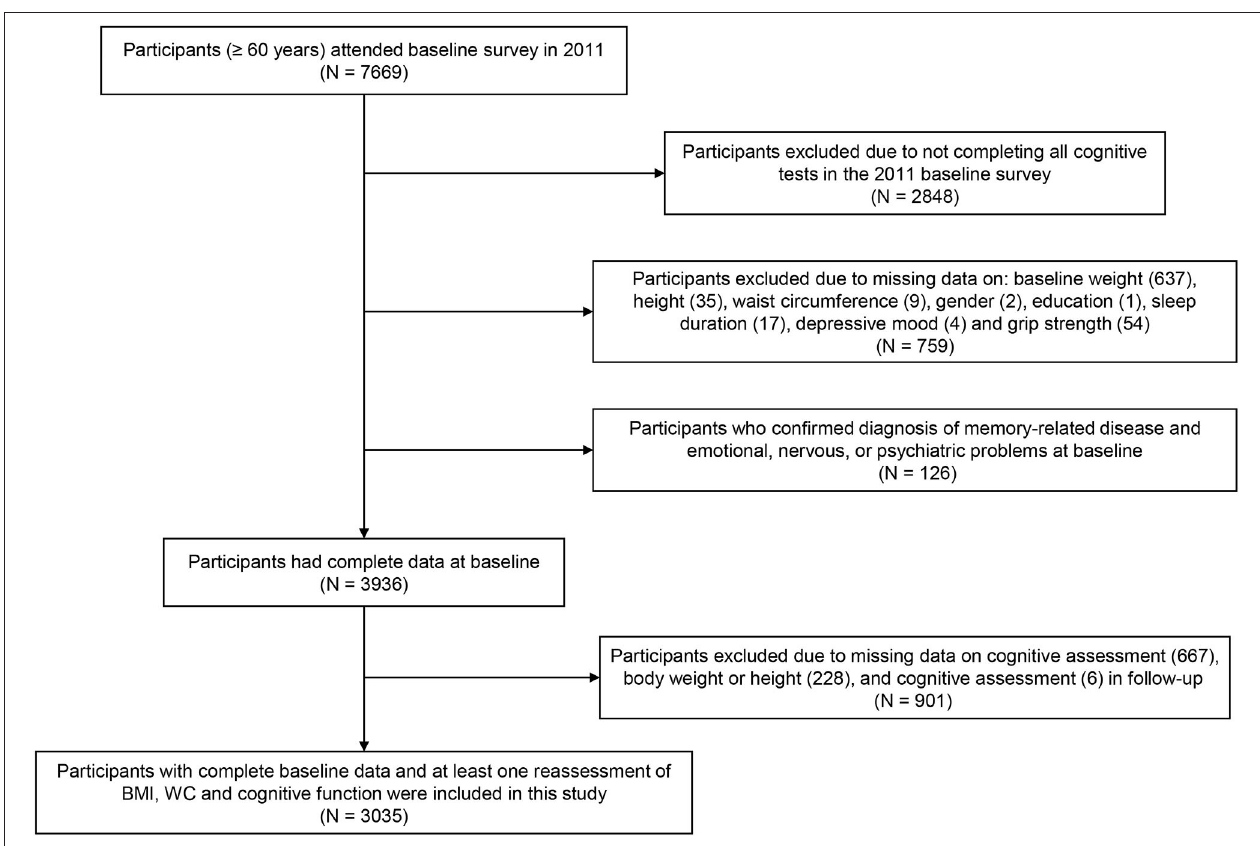
FIGURE 1 | Flowchart of